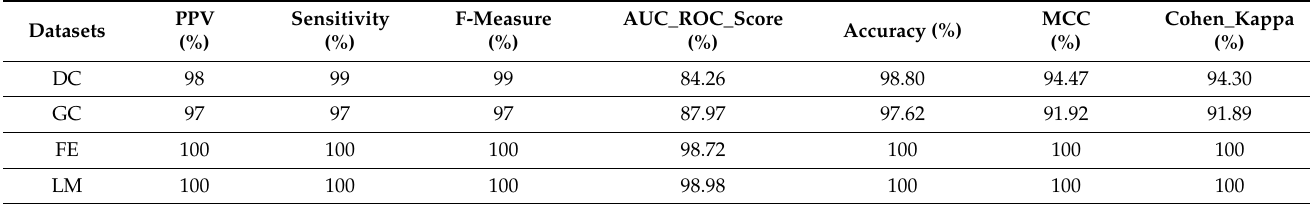
Table 5. Results of AdaBoost algorithm.